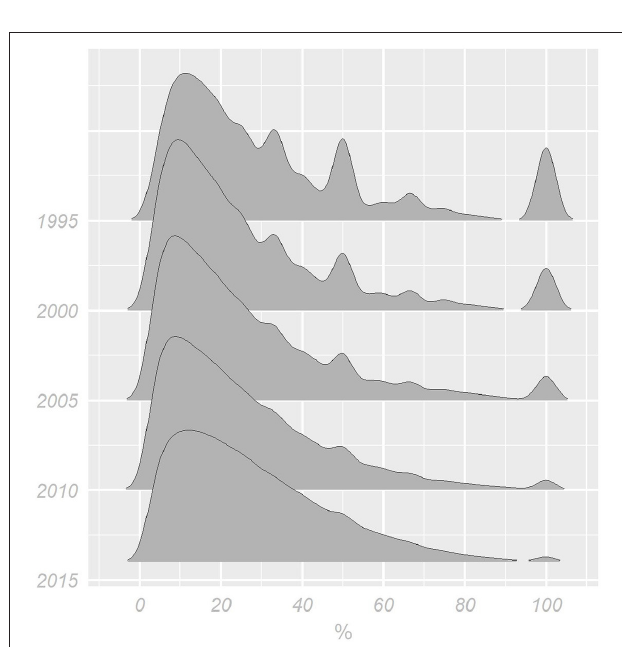
FIGURE 4 | Share of Chinese national self-citations.